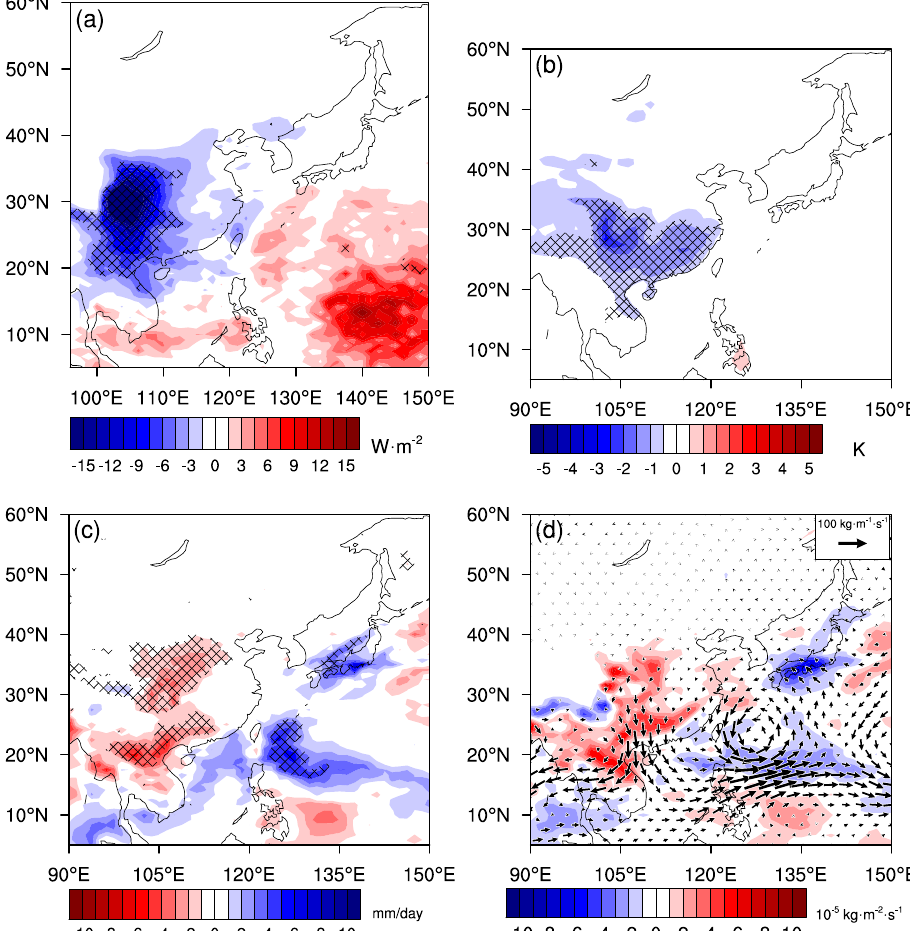
Fig. 8. (a) Eighteen-year mean net radiative flux (downward is positive) in September due to sulphate combined effect (Control minus SO 2 1950). Units: Wm − 2 . The blue box indicates East Asia (20–45 ◦ N, 100–122 ◦ E), the area mean value is shown above the to-right conner of the blue box. (b) Eighteen-year mean change in surface temperature in September for sulphate experiment. Units: K. (c) Eighteen-year mean change in precipitation in September for sulphate experiment. Units: mmday − 1 . (d) Eighteen-year mean change in vertical integrated (surface to 700hPa) moisture flux (vector, Units: kg/m/s) and moisture flux divergence (shaded, units: kgm − 2 s − 1 ) for BC experiment. Significant changes excess 95% confident level are hatched. 33